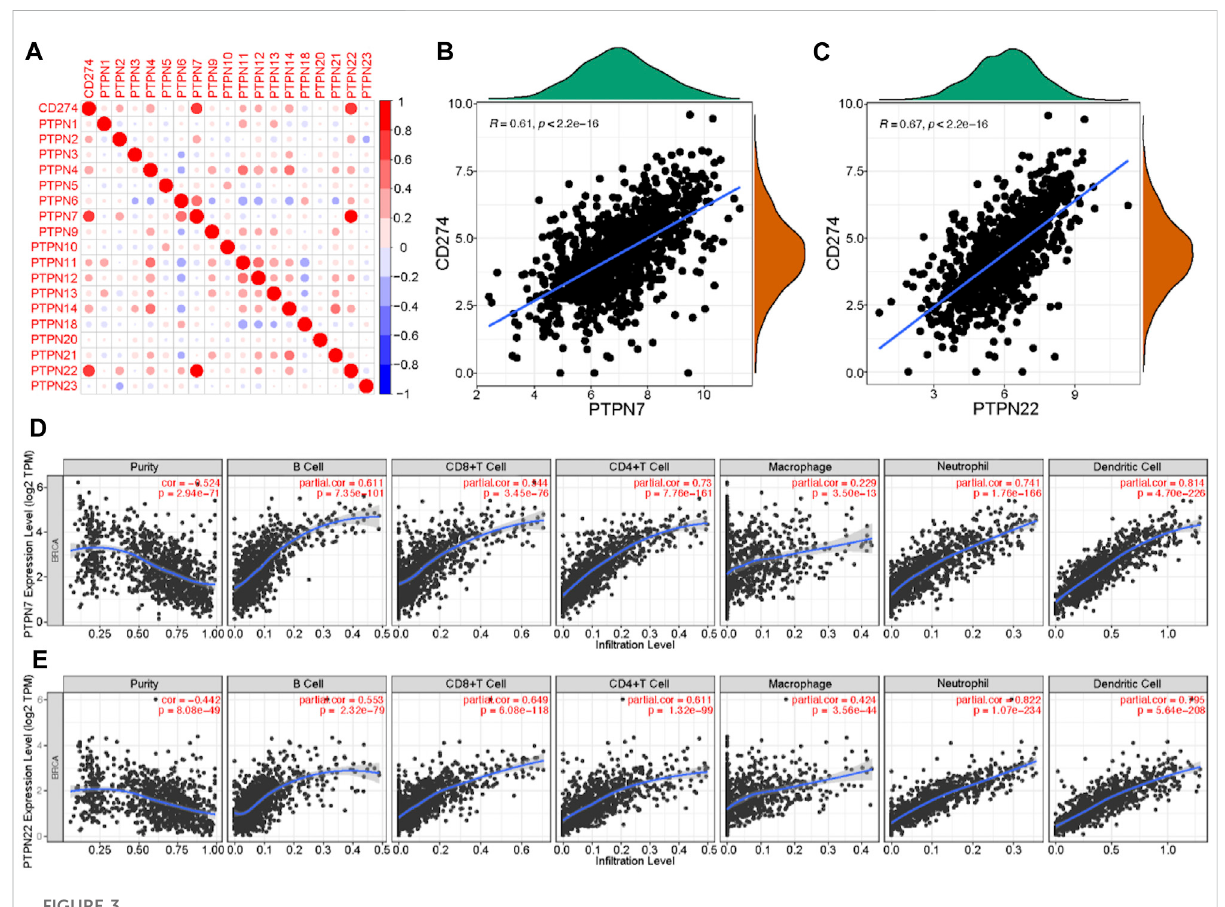
FIGURE 3 Correlations between PTPNs and PD-L1 as well as immune in fi ltration in BrCa. (A) PTPNs and their correlation with programmed cell death- ligand 1. Red: positive association, blue: negative association. (B,C) Correlation between PTPN7 and PTPN22 and PD-L1. (D,E) Correlation of PTPNs expression with immune in fi ltrating level in BrCa. expressions were signi fi cantly positively related to tumor purity. While PTPN7 and PTPN22 expressions were signi fi cantly positively correlated with in fi ltrating levels of CD8 T cells, CD4 T cells, macrophages, neutrophils, and dendritic cells in